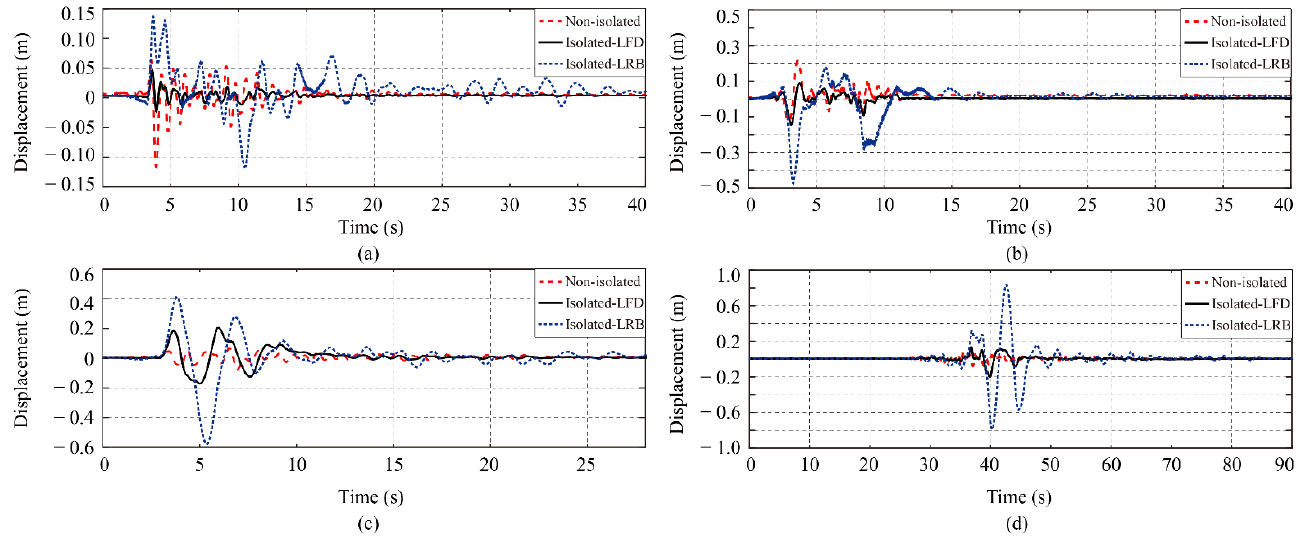
Figure 12. Relative displacement within the bearing time histories at pier 4 for the original system (Non-isolated), LFD system (Isolated-LFD), and LRB system (Isolated-LRB) with ( a ) wave 2, ( b ) wave 6, ( c ) wave 9, and ( d ) wave 12 in Table 1.